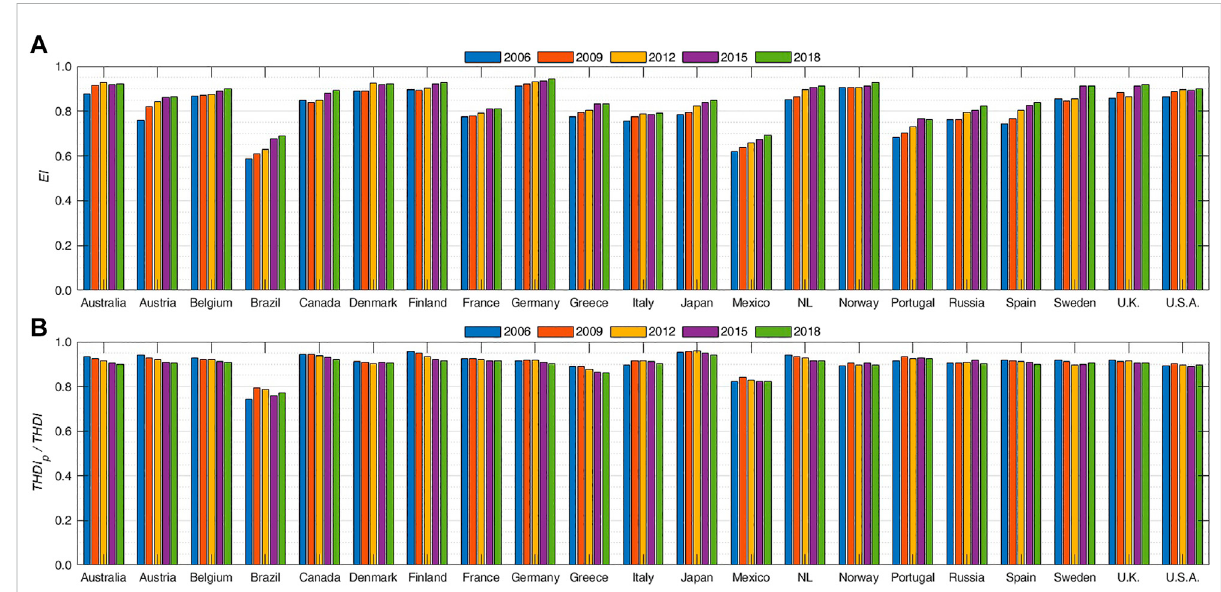
FIGURE 2 (A) ValuesoftheUnitedNation ’ sEducation Index EI in2006,2009,2012,2015,and2018forthefollowingcountries:Australia,Austria,Belgium, Brazil, Canada, Denmark, Finland, France, Germany, Greece, Italy, Japan, Mexico, the Netherlands (NL), Norway, Portugal, Russian Federation (Russia), Spain, Sweden, the United Kingdom (UK), and the United States of America (USA). The UN ’ s EI data have been retrieved from the United Nations Development Program - Human Development Report database [47]. (B) Ratio between the Thermodynamic Human Development Index professional-oriented, THDI p , and the original one, THDI , of the same countries in the same years. Data to perform their evaluation have been retrieved in the following datasets [47 –